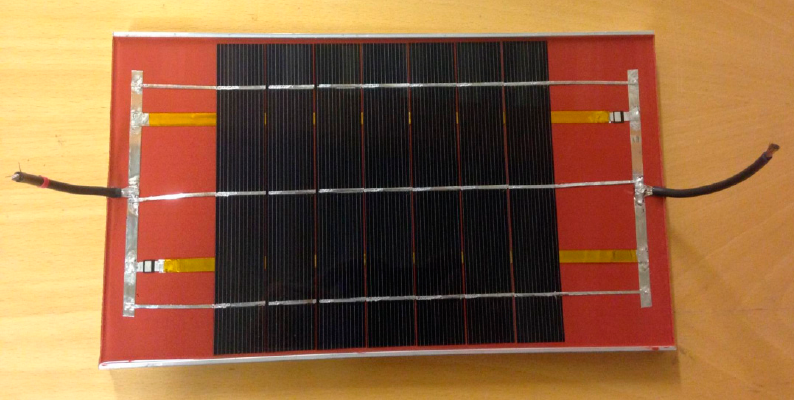
Figure A1. Receiver 1 has seven 1/6 cells with a standard cell gap, line soldering, red and transparent silicon and no strain relief.